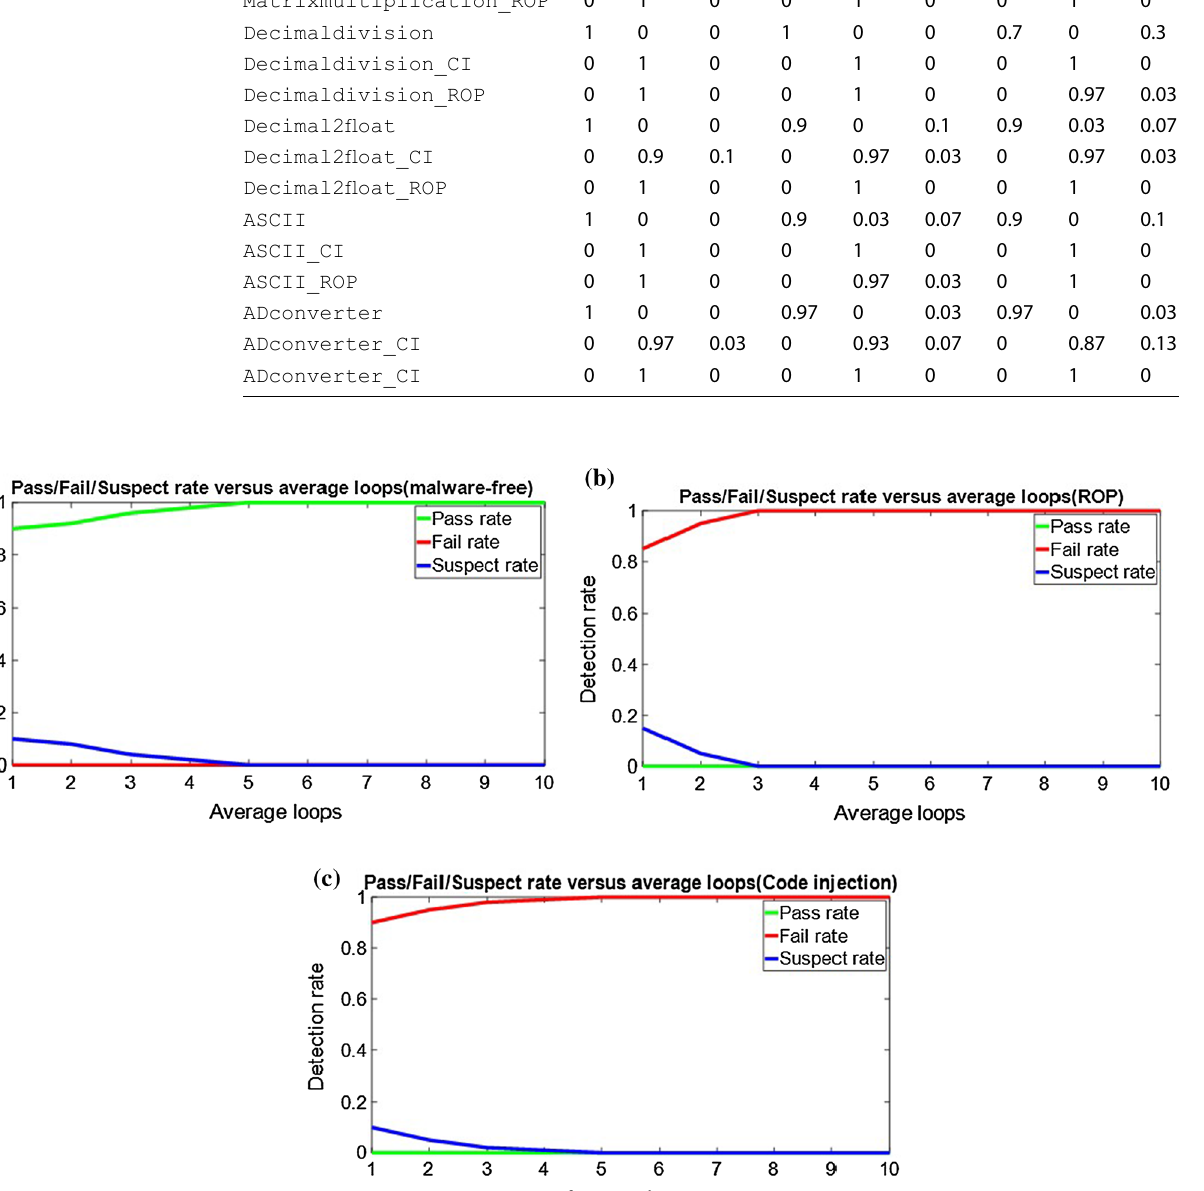
Table 2 Experimental results for malware detection on 6 benchmarks in 3 scenarios on 3 boards out using a PC for offline verification. P i , F i , and S